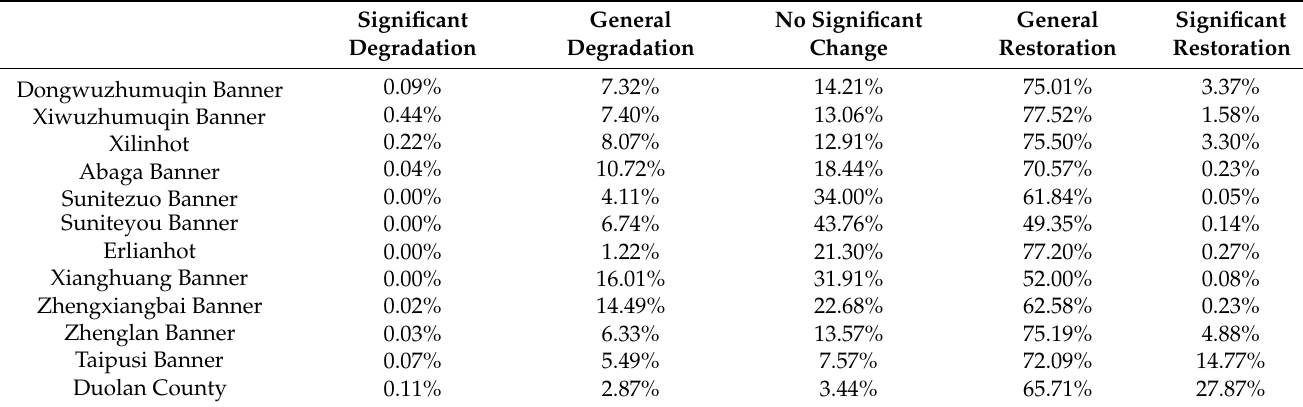
Table 3. Percentage of grassland variation trends in different zones. Significant General No Significant Degradation Degradation Change